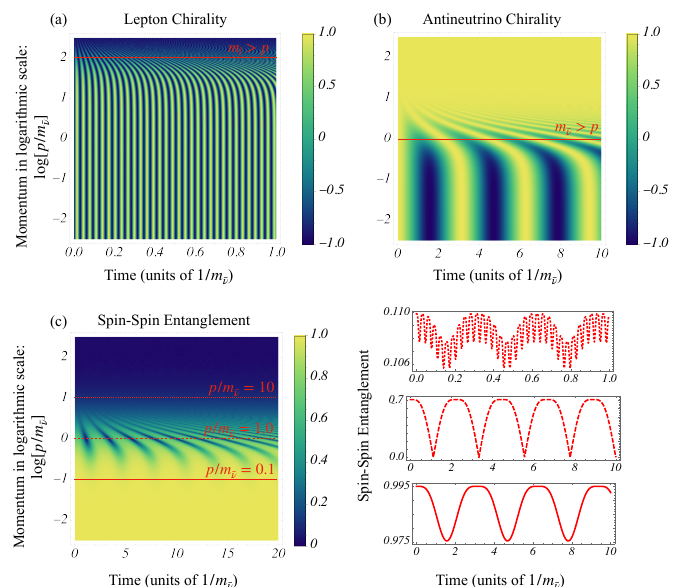
Figure 3. ( a ) Average lepton chirality, ( b ) average antineutrino chirality, and ( c ) spin-spin entangle- ment as a function of the momentum (in units of the antineutrino mass and in log scale) and of time. In ( a , b ) for m l ,¯ ν < p , chiral oscillations are suppressed. Correspondingly, the spin-spin entanglement exhibits a behavior similar to the antineutrino chirality: for m ¯ ν Results for m l / m ¯ ν = 10 2